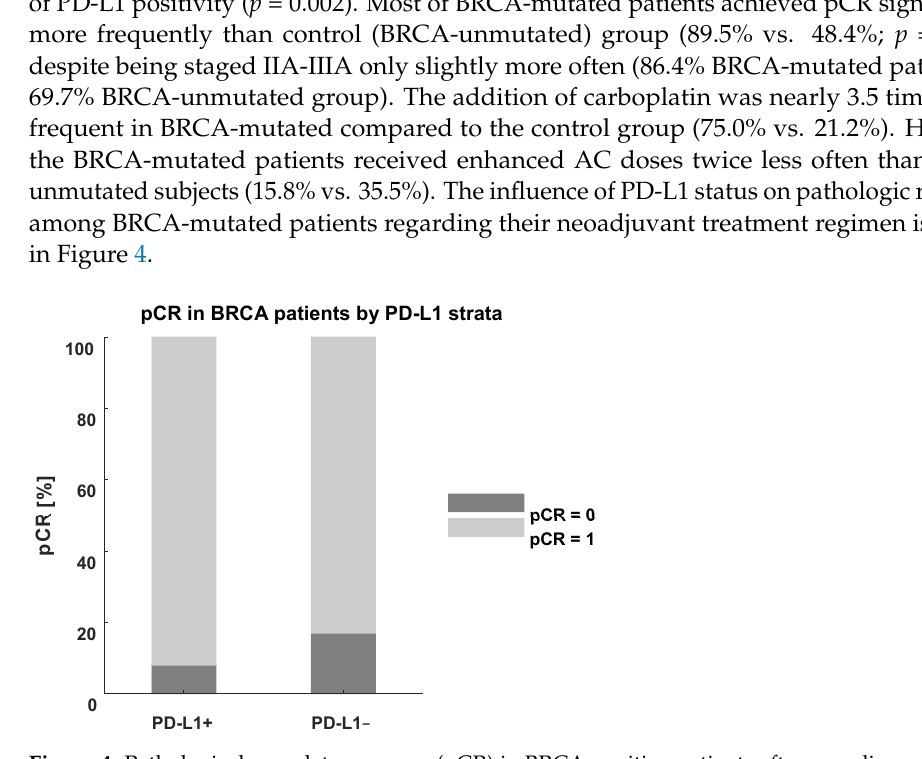
Figure 4. Pathological complete response (pCR) in BRCA-positive patients after neoadjuvant therapy by PD-L1 strata.